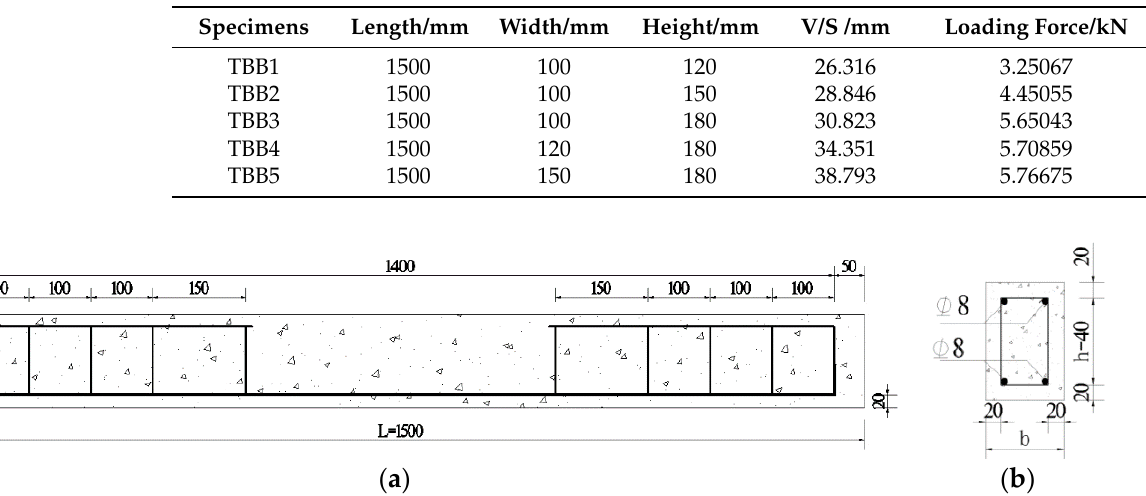
Table 8. Main parameters of test beam.